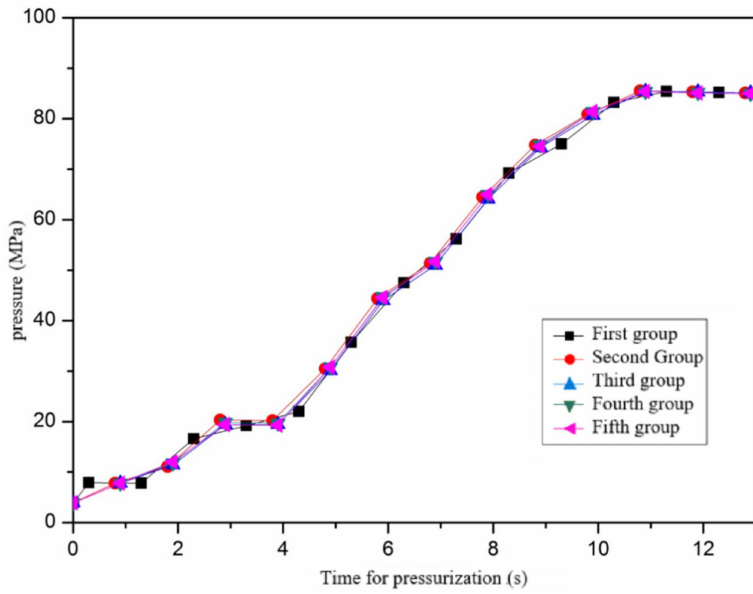
Figure 23. Pressure time curve of six hose